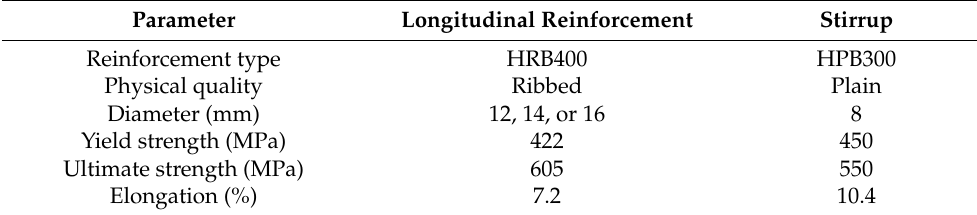
Table 4. Parameters of the longitudinal reinforcement and stirrup.